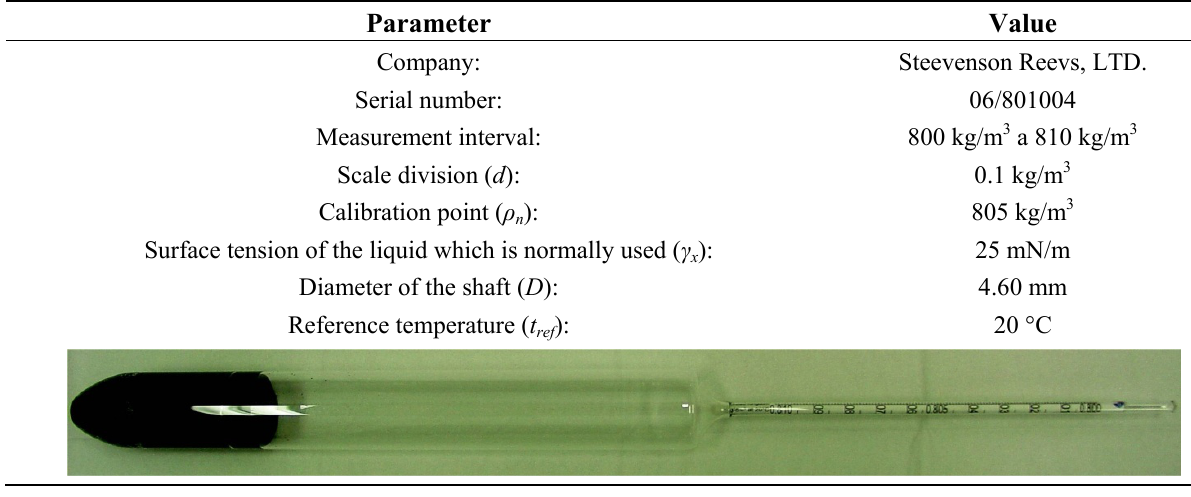
Table 1. Characteristics of the high accuracy immersion hydrometer.